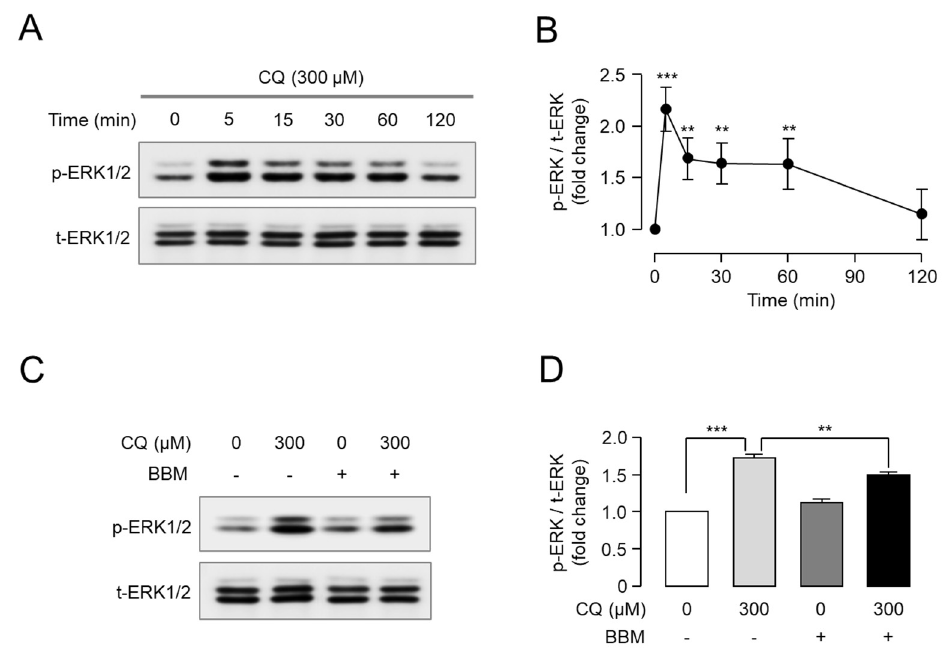
Figure 6. Effect of berbamine on CQ-induced ERK1/2 phosphorylation through MrgprA3: ( A ) Rep- resentative immunoblot analysis results of ERK1/2 phosphorylation in CQ-treated HEK293T